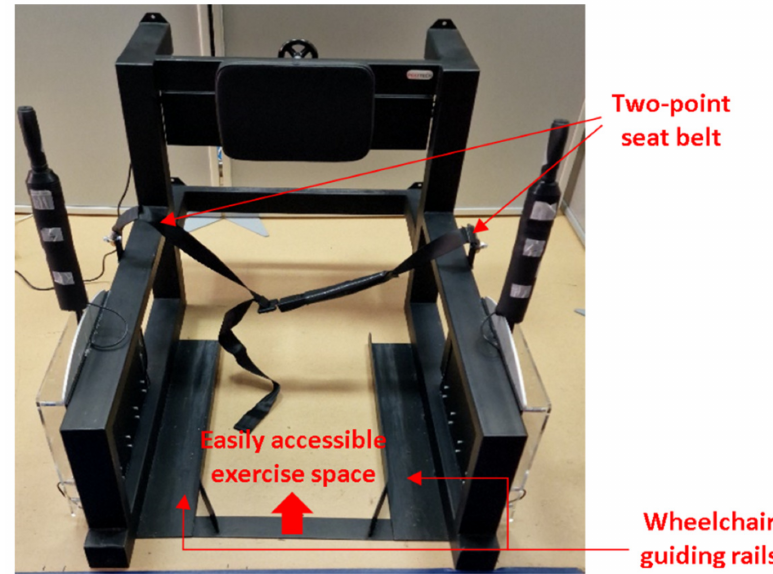
Figure 2. Front view of the